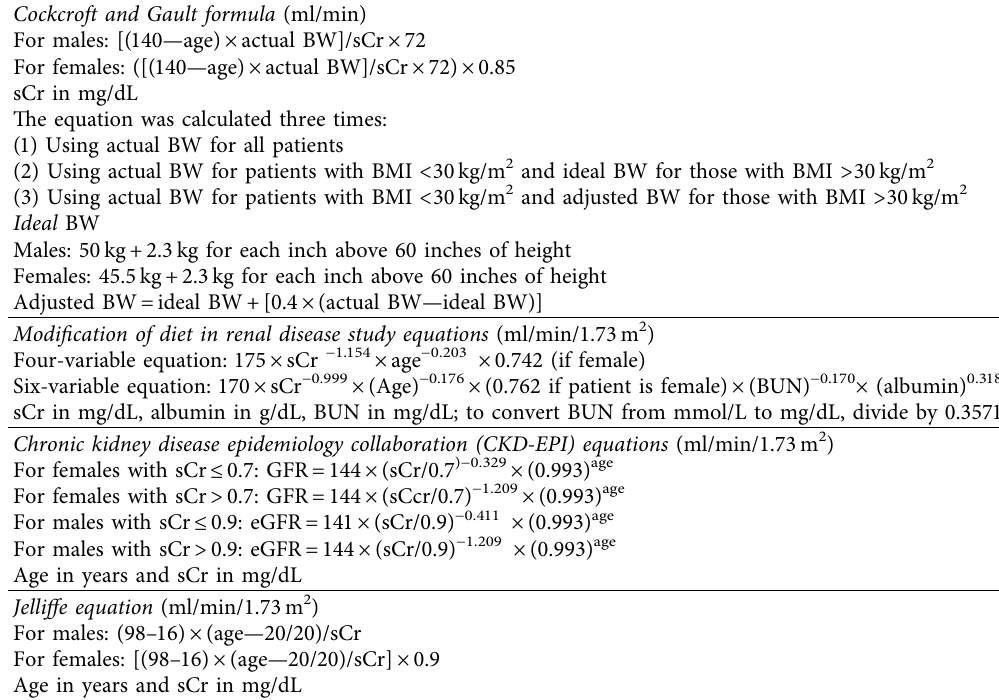
Table 1: Renal function estimating